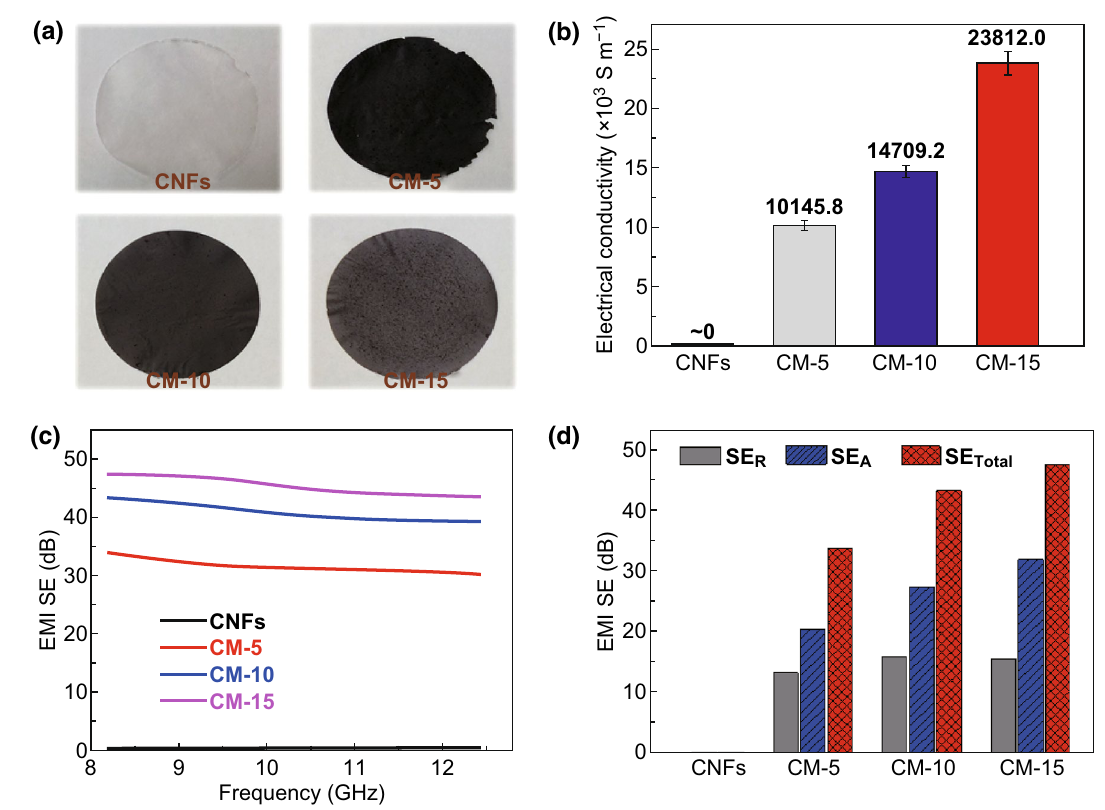
Fig. 4 a Digital images of single‑layered CNFs, CM‑5, CM‑10, and CM‑15. b Electrical conductivity and c EMI SE of single‑layered CNFs, CM‑5, CM‑10, and CM‑15 in the X‑band region. d Comparison of SE Total , SE A , and SE R of single‑layered CNFs, CM‑5, CM‑10, and CM‑15 at the frequency of 8.2